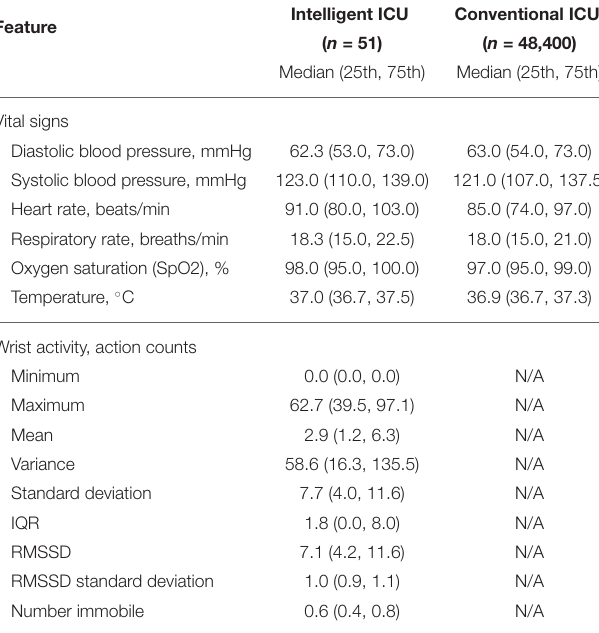
TABLE 1 | Summary of Intelligent ICU and Conventional ICU cohorts. TABLE 2 | Summary of features used in our